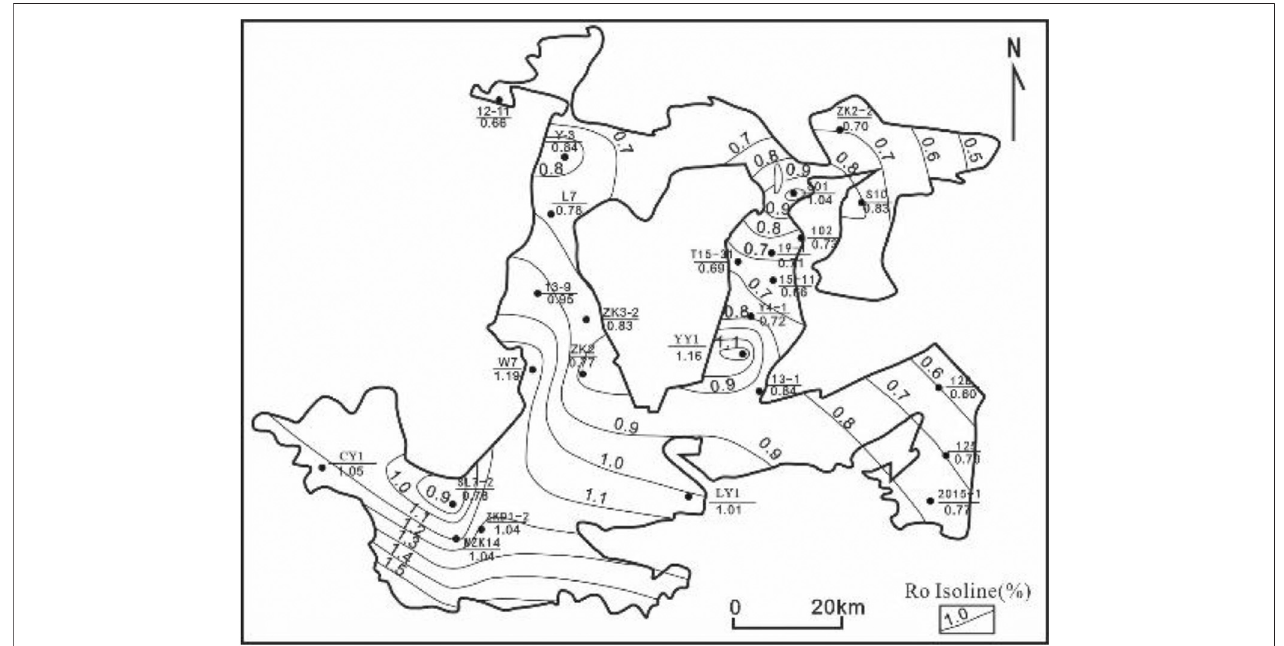
FIGURE 8 | Organic matter maturity distribution in the Shanxi and Taiyuan Formations.